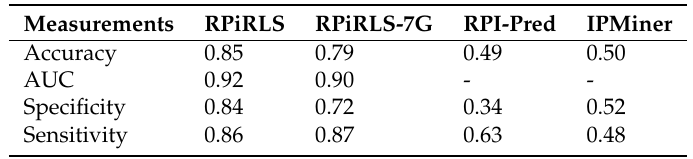
Table 4. Comparision of RPiRLS with other methods on the RPI369 data set in predicting RNA-protein interactions with known structures.